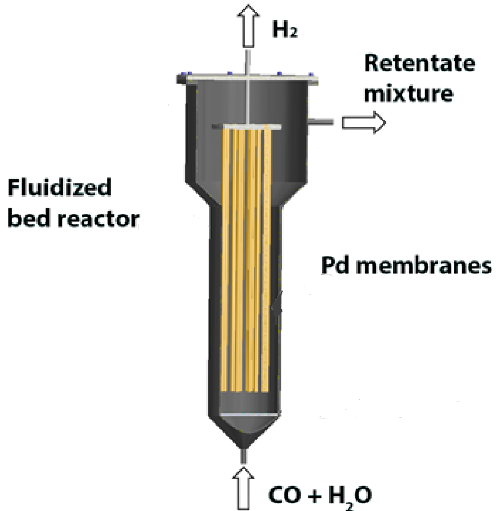
Figure 1. A schematic representation of a fluidized bed membrane reactor for water gas shift reaction.